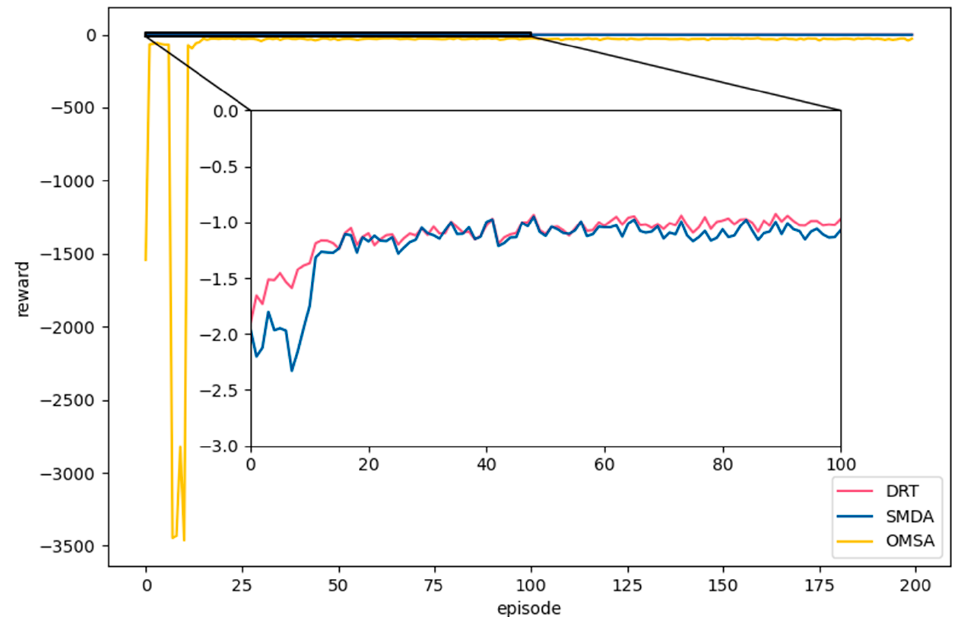
Figure 7. Comparison of reward with SMDA and OSMA.